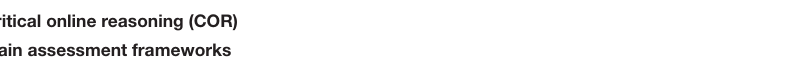
TABLE 1 | Theoretical and conceptual background of